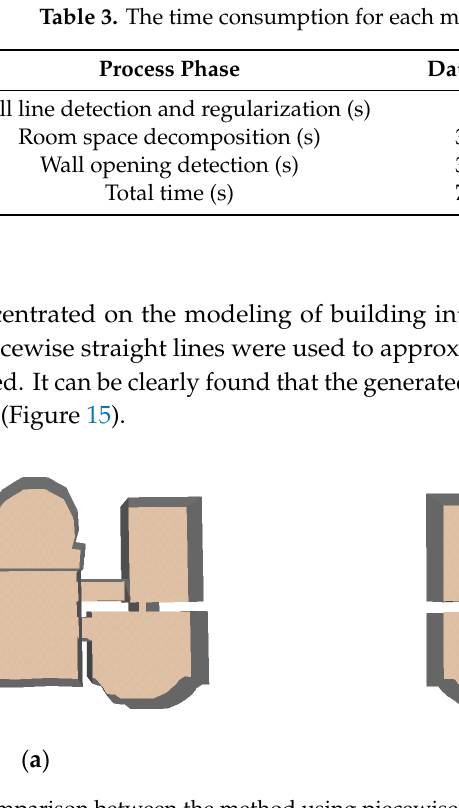
Figure 15. The comparison between the method using piecewise straight lines to approximate curved line ( a ) and proposed method ( b ).This study proposed a point-based method for curve detection of slice point cloud. The problem can also be solved in 2D domain by projecting the slice point cloud in XOY plane and using image-based method [36]. The image-based method often contains two steps, thinning [37,38] and tracing. It is useful and can detect curved lines quit well. However, the method still has two problems when compared with proposed method.